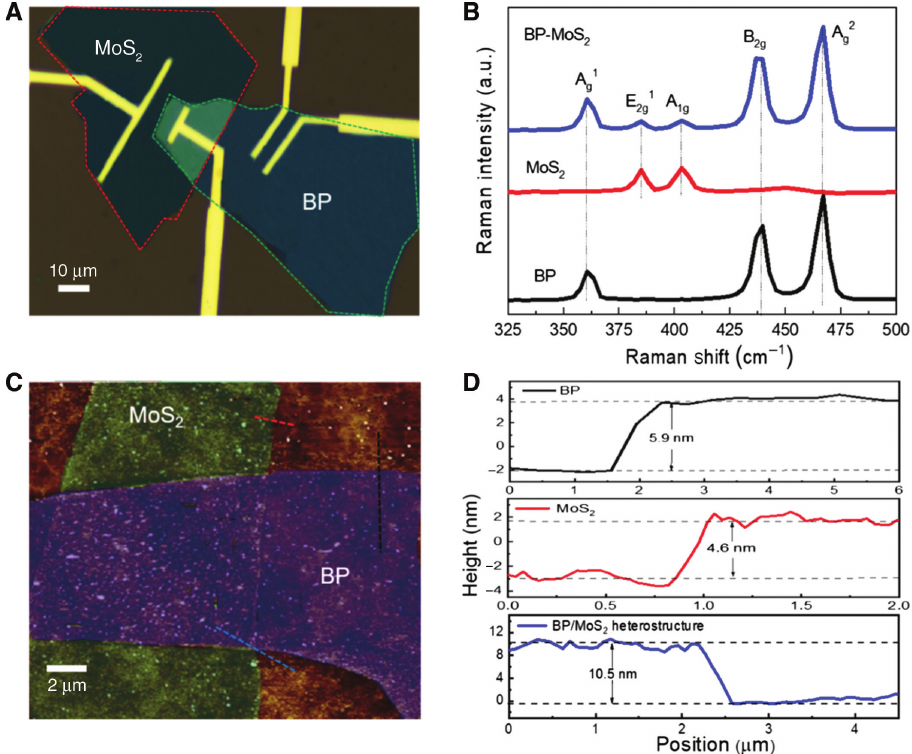
heterostructure. 2 heterostructure on the SiO /P + -Si substrate. (B) Raman spectra obtained from MoS 2 2 /BP flakes. (D) AFM height profile of MoS /BP flakes along the dashed line in (C). 2 2